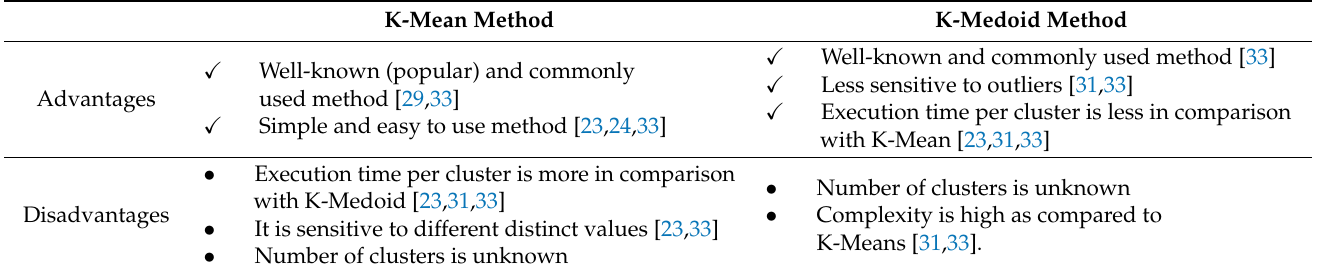
Table 1. Advantages and disadvantages of K-Mean and K-Medoid methods. K-Mean Method K-Medoid